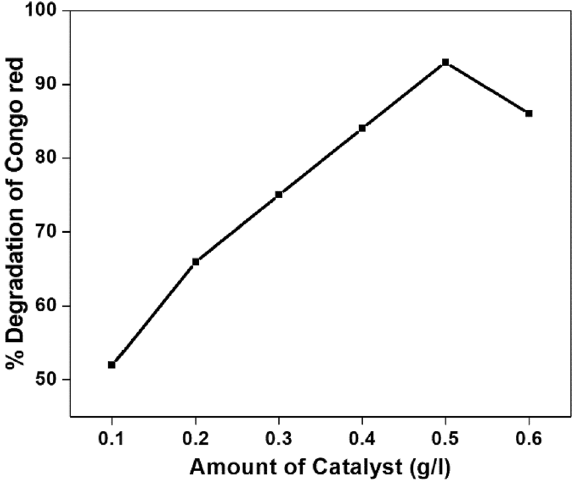
Figure 18. Effect of Catalyst Dosage on the photo degradation of Congo red [Congo red] = 20 µM, pH = 4, Amount of NT1 = 0.5 g l −1 .